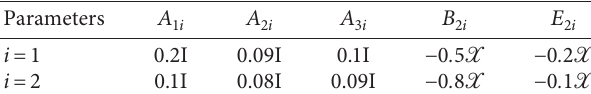
Table 3: Parameters with different